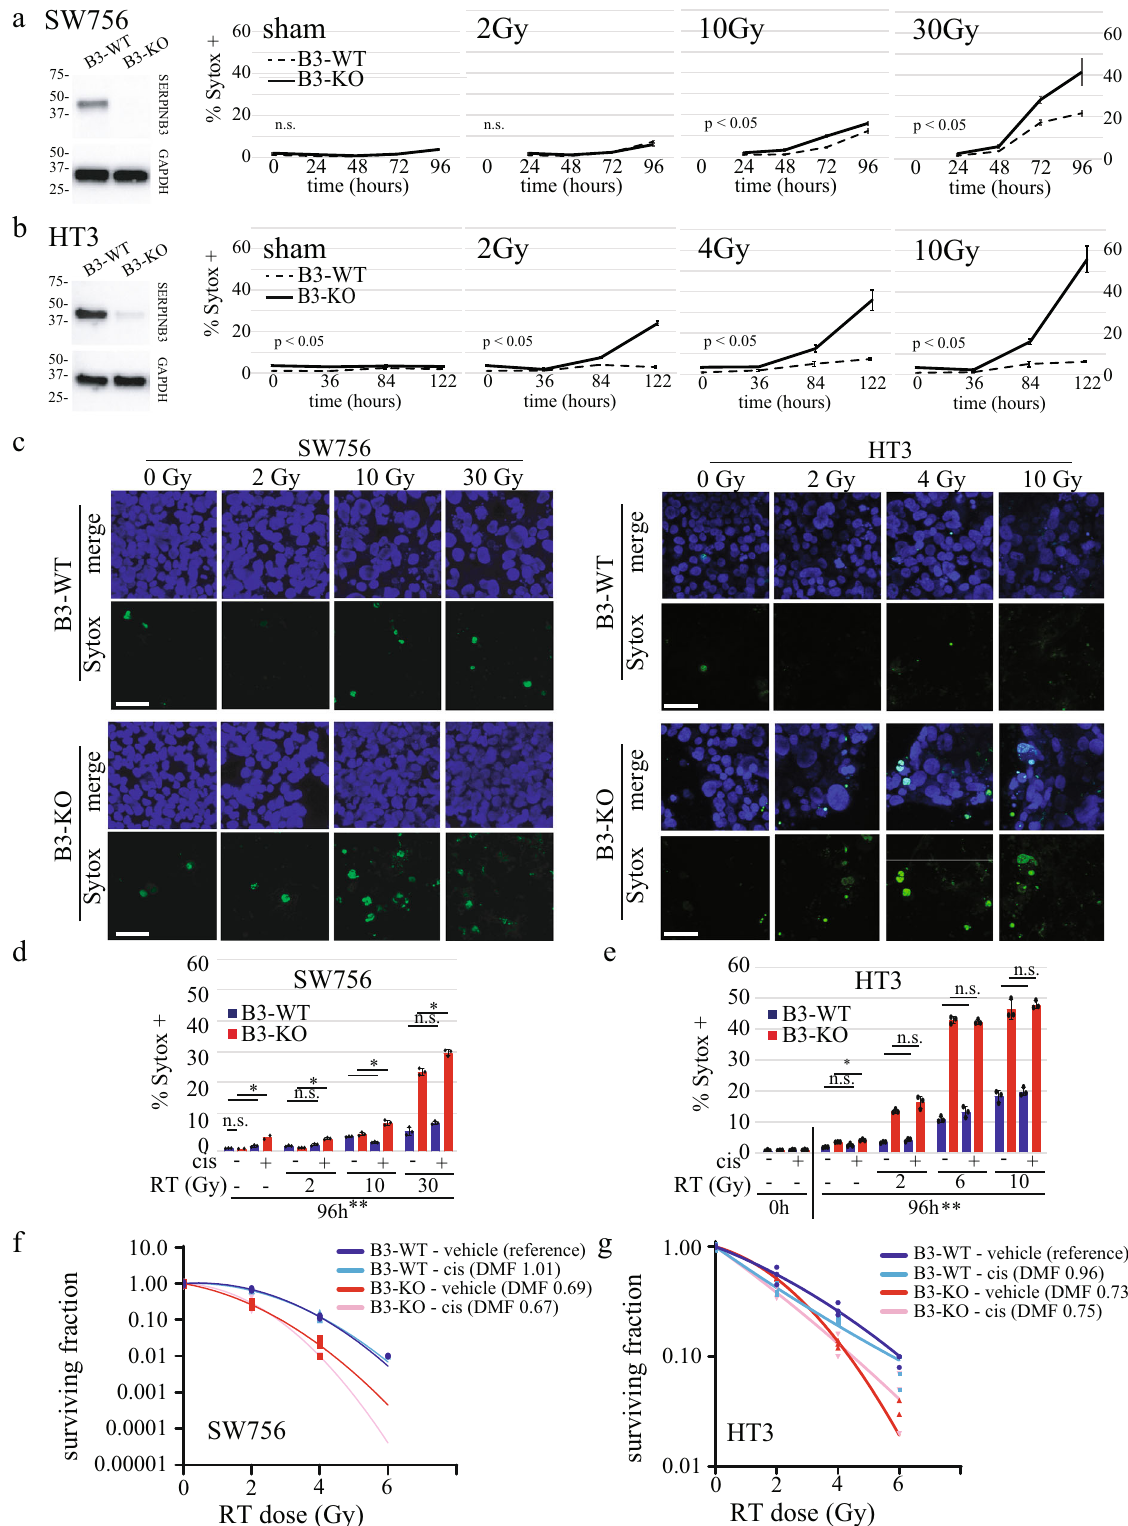
absolute difference in cell death in the SW756 background, and 50% in the HT3 background (Fig. 1a – c). We then compared the effect of single gene knockout of SERPINB3 on radiosensitivity with or without cisplatin chemotherapy, the radiosensitizing agent used as standard of care for the treatment of patients with cervical cancer. We found that the effect of B3-KO on both cell COMMUNICATIONS BIOLOGY| (2022) 5:46